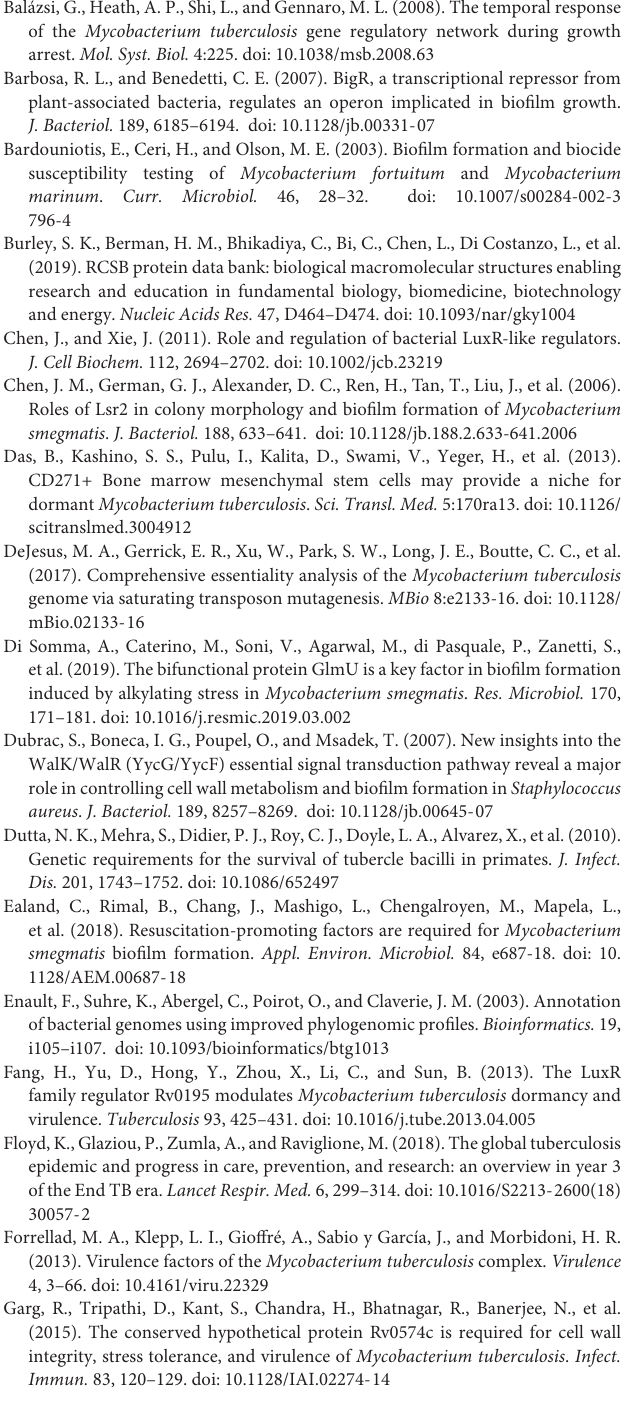
TABLE S4 | List of high centrality nodes in the BQAP molecular interaction network. TABLE S5 | Interactions between nodes in the identified network